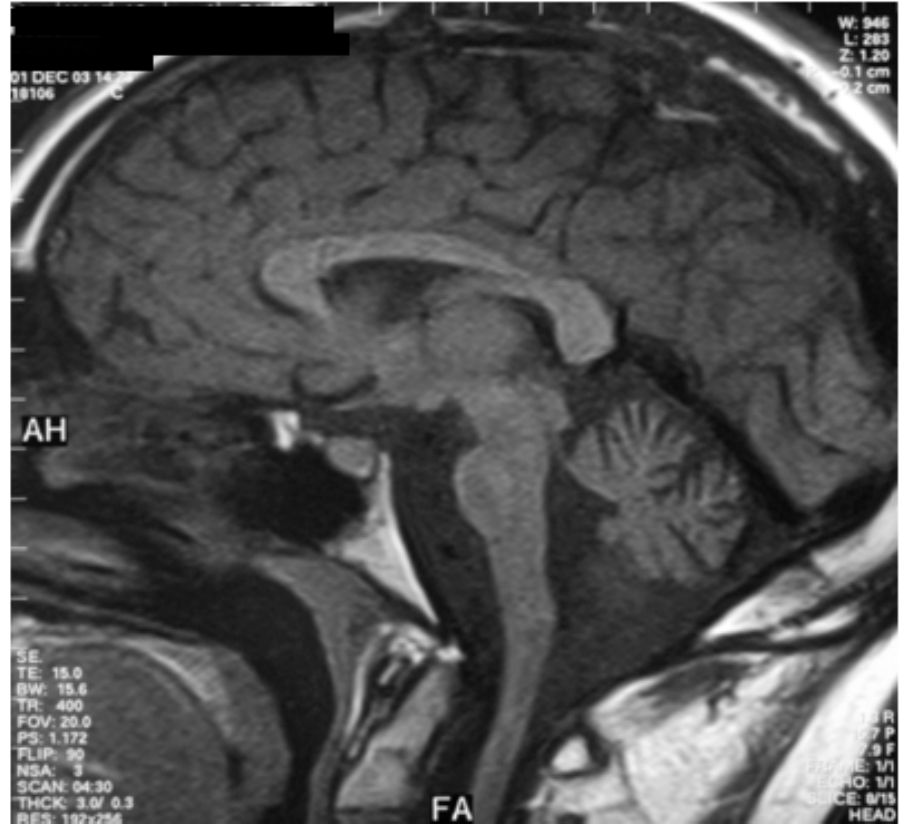
Figure 1. Brain magnetic resonance showing pons and cerebellum hypoplasia (personal observa- tion